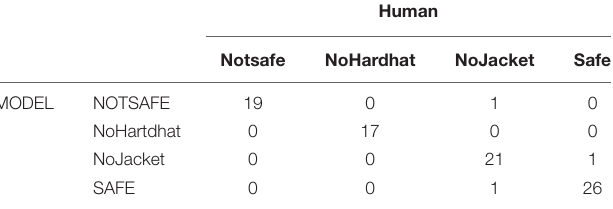
TABLE 4 | Confusion matrix for the test set.